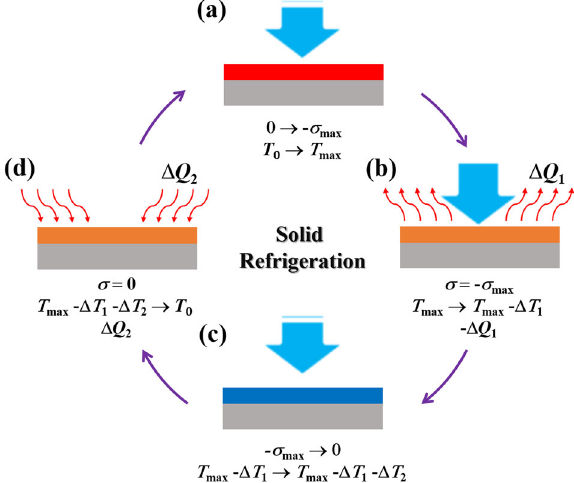
Fig. 1 Schematics of an eC refrigeration cycle. The cycle is divided into four steps: ( a ) compressive stress applying on the elastocaloric material, the release of latent heat and related temperature rise, ( b ) heat transfer to the surroundings when the stress is fi xed at σ max , ( c ) compressive stress removed gradually, uptake of latent heat and related temperature drop, ( d ) heat transfer to the elastocaloric material when the stress is fi xed at 0. Elevated temperatures are represented in red and orange, decreased temperatures are in blue.